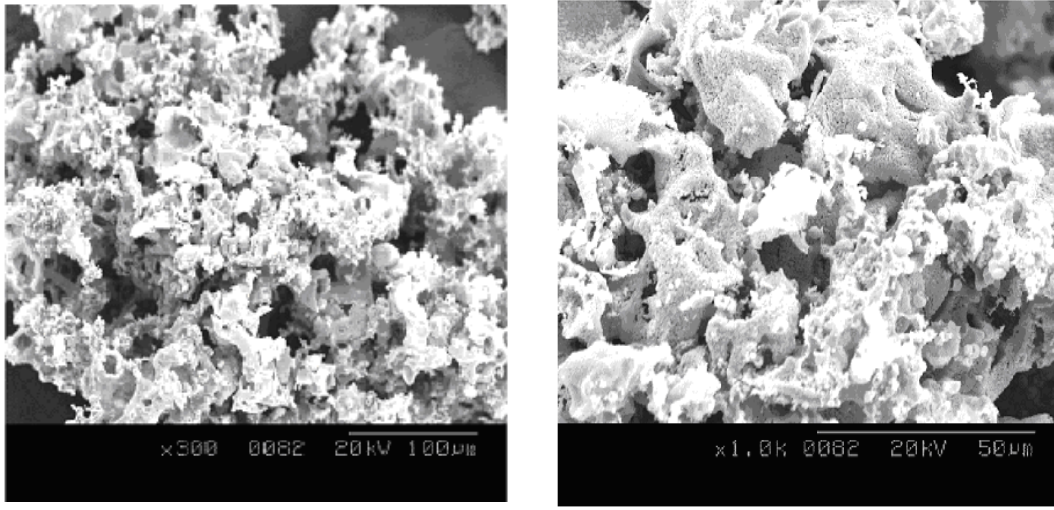
Figure 6. SEM photographs of Ni nanofibers after grinding with different magnifications: at low magnification (left), and at high magnification (right).